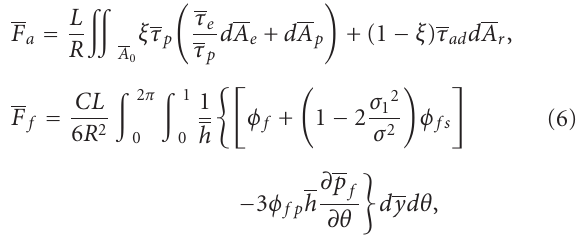
( S o = 10 0 ) (b) distributions of fluid pressures p f ( S o = 10 − 2 ); (d) distributions of asperity-contact pressure p f